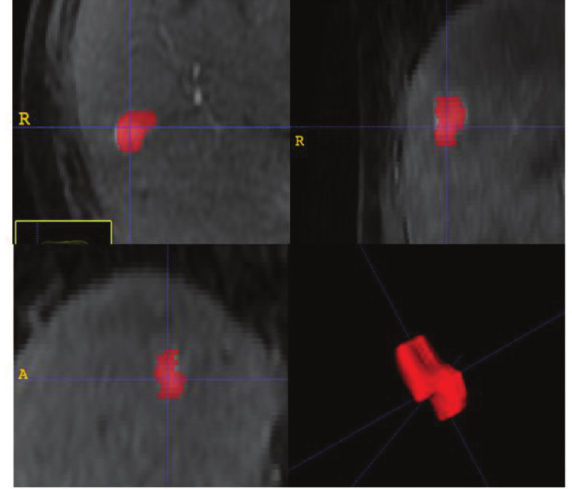
Figure 2 - Multiplanar reconstruction illustrating the manual segmentation of the entire volume of interest of a liver lesion for extraction of quantitative